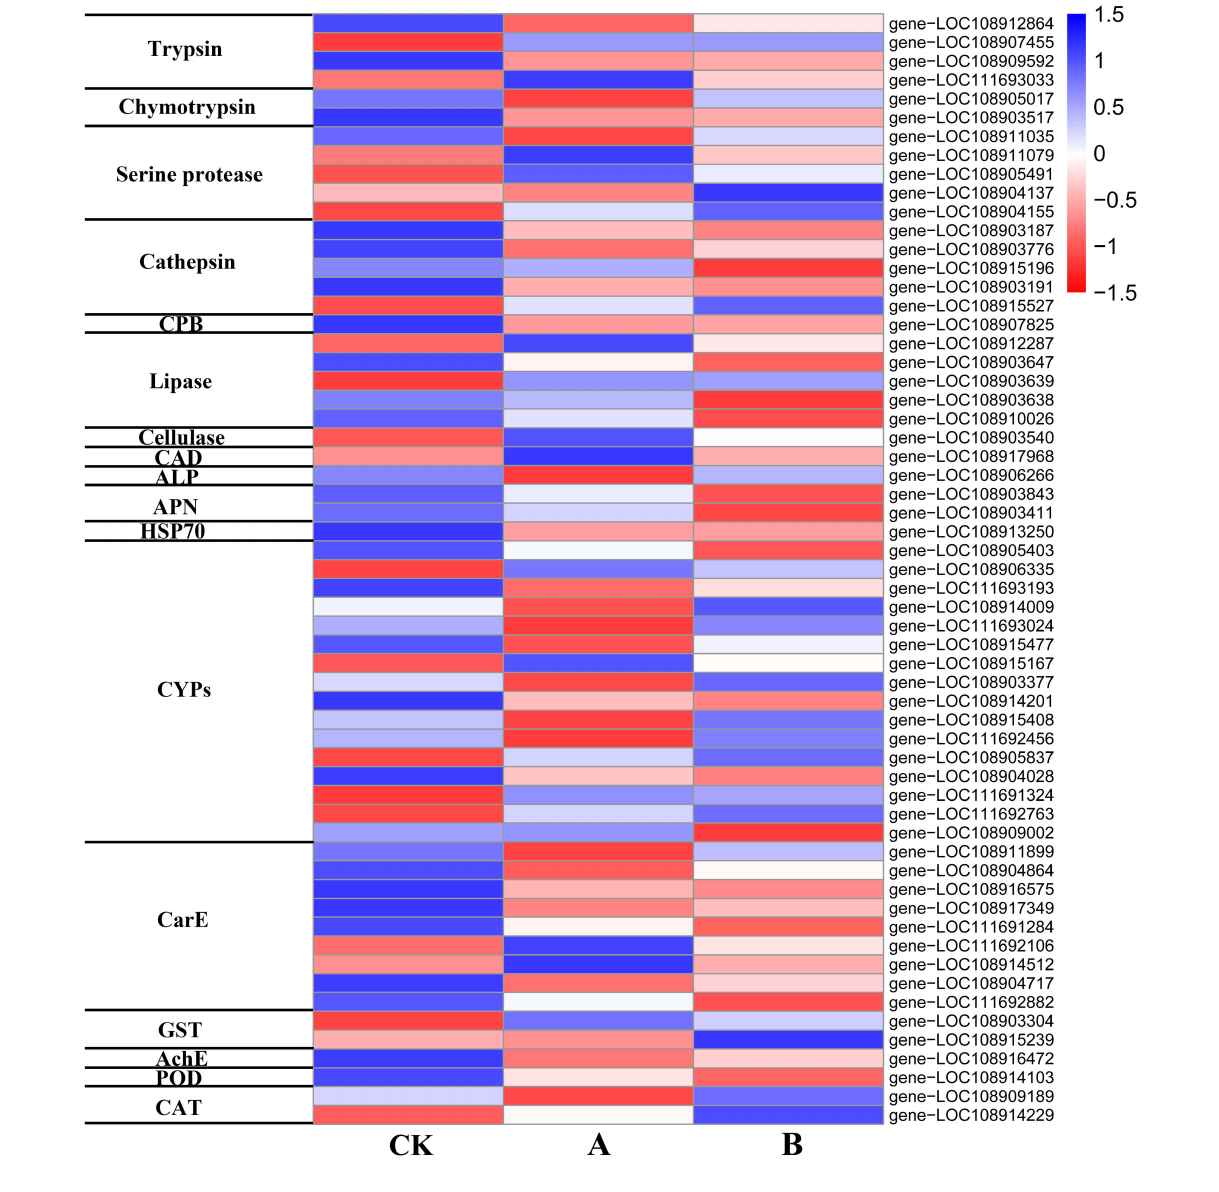
FIGURE 7 | Heat map of DEG